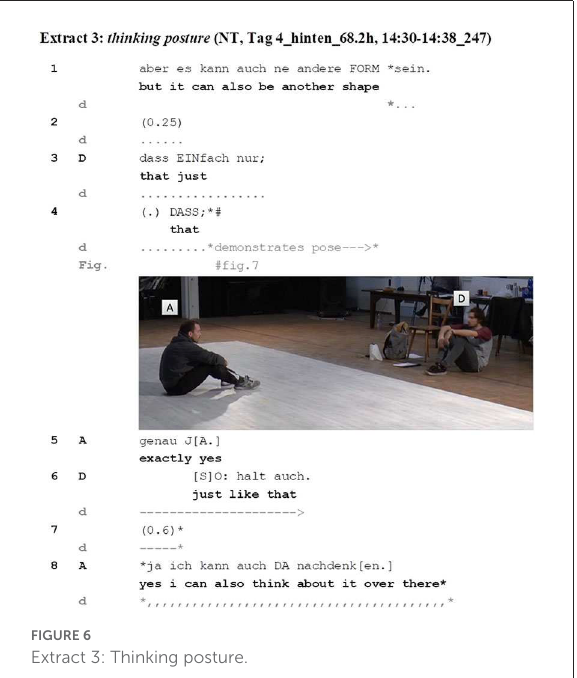
FIGURE6 Extract 3: Thinking